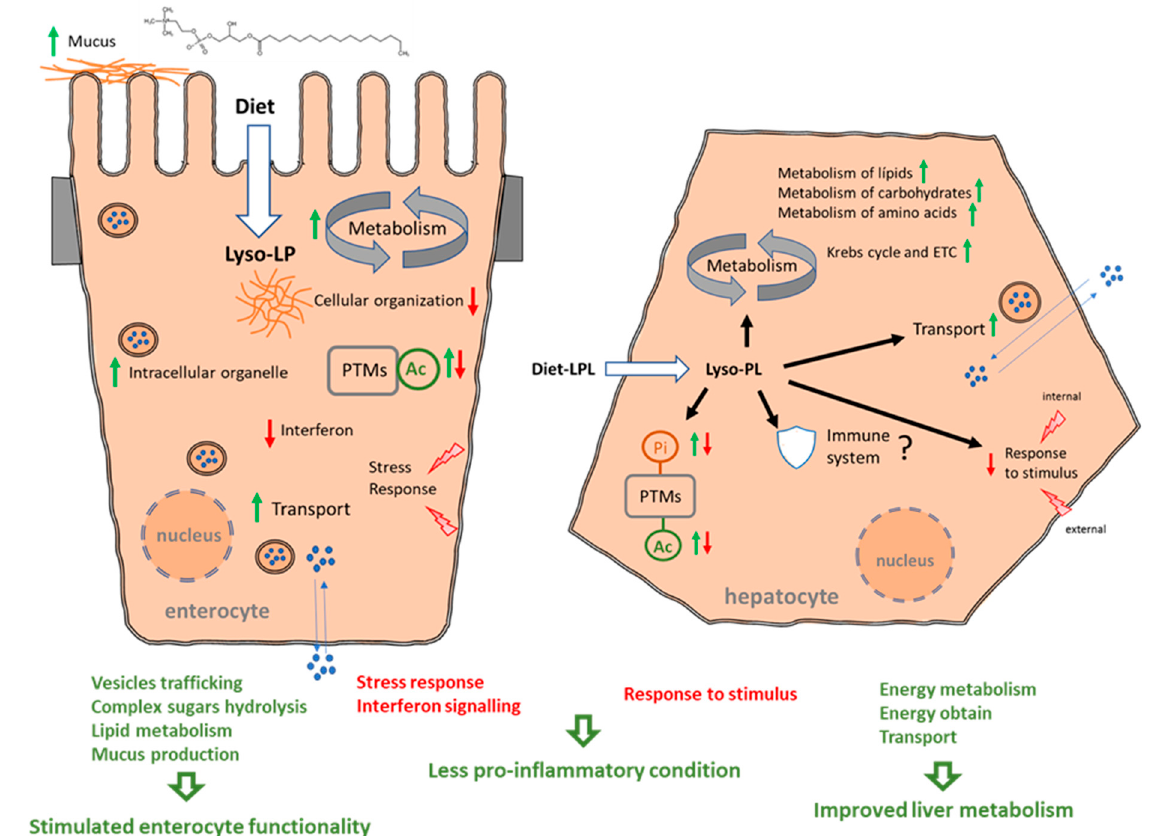
Figure 9. Summary of the modes of action of dietary LPLs in salmon intestine and liver. Green arrows mean upregulated processes and red arrows indicated downregulated processes.